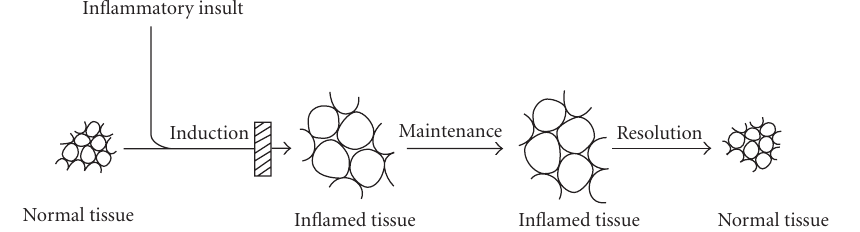
Figure 2. Site-specific inhibition of carrageenan-induced paw inflammation by PPAR agonists. The hatched bar indicates the site at which PPAR agonists interfere with the inflammatory process.